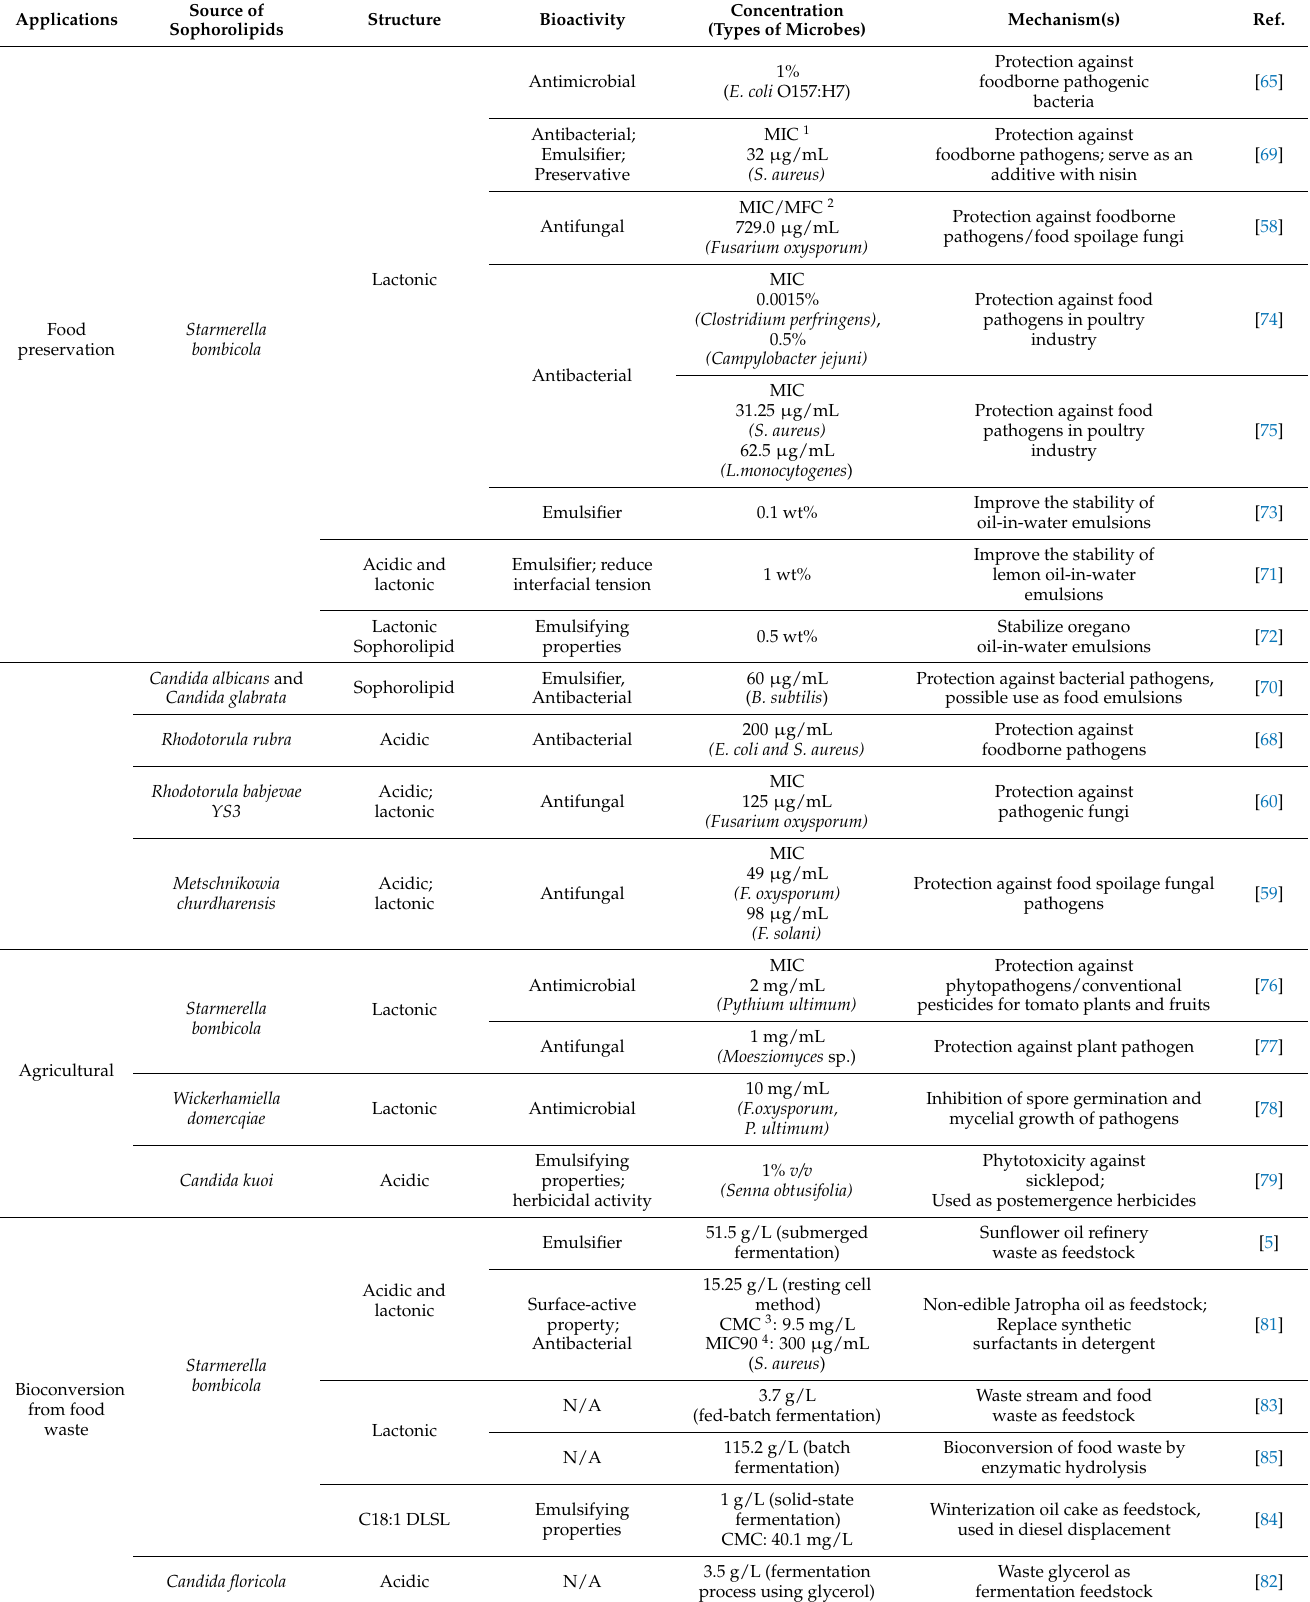
Table 1. Application of sophorolipids in the food